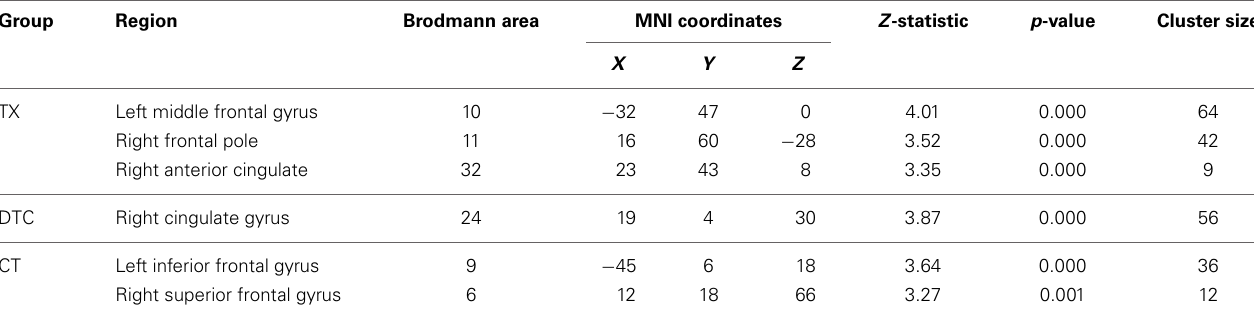
Table 4 | Within-group frontal ROI gray matter volume increases between pretest and posttest for each group separately. Group Region